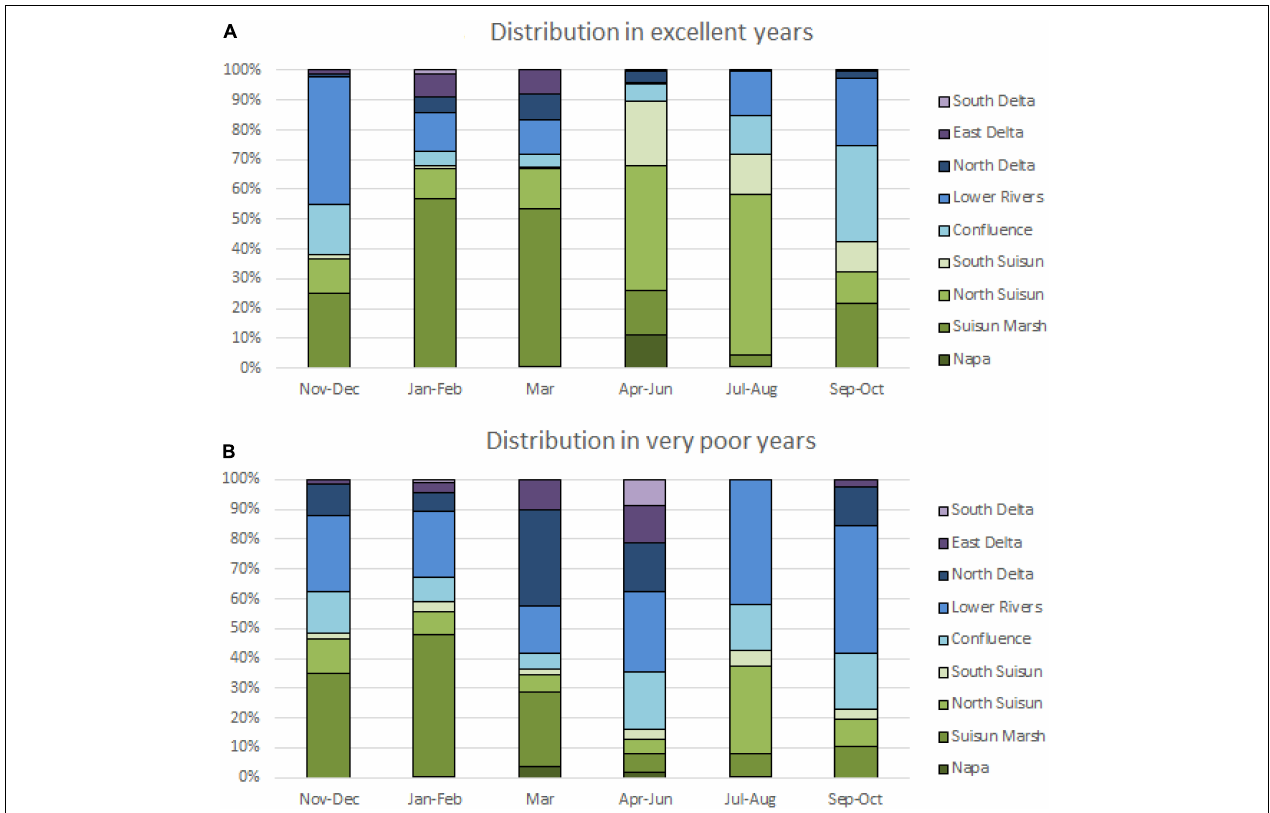
FIGURE 4 | Average distribution of delta smelt by months in years of excellent performance (A) and very poor performance (B) with western subregions shown in shades of green and eastern subregions shown in shades of blue and